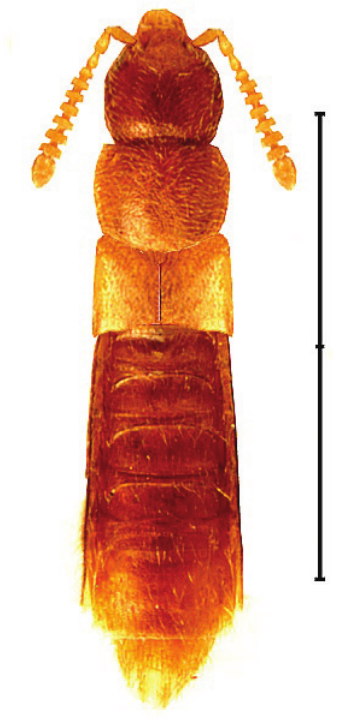
Fig. 4. Dorsal habitus photograph of Meo- tica “pallens” sensu Benick and Lohse